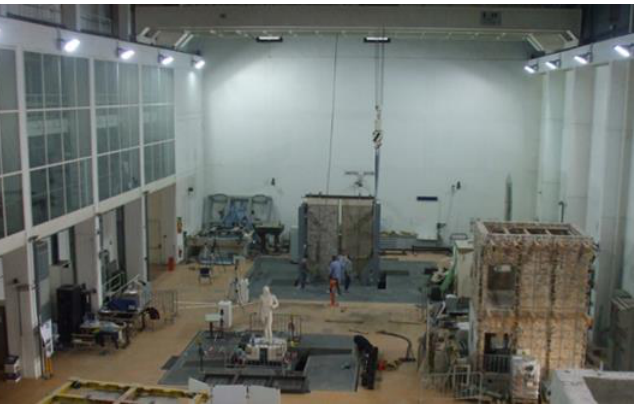
Figure 1. View of the ENEA Casaccia shaking tables hall. The hall lighting system by high-power floodlights is visible on top of lateral